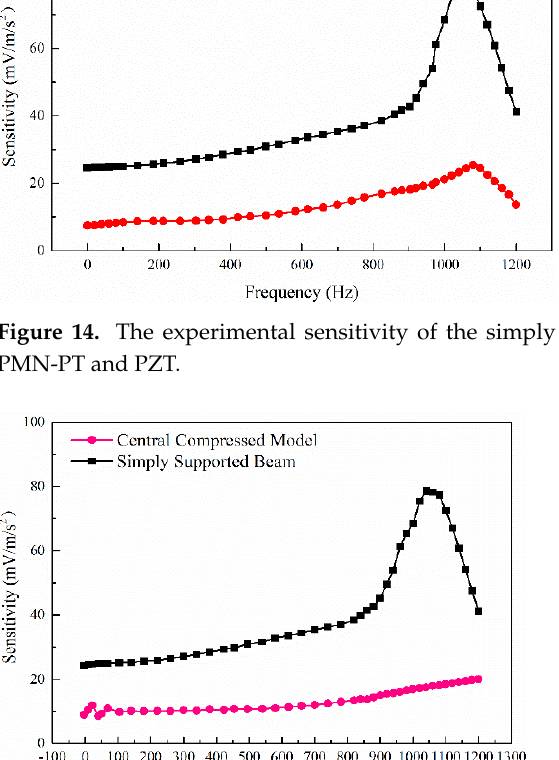
Figure 16. The waveform of different models at 1 Hz. 3.2. Output Results of the Data Acquisition System The model of the piezoelectric transducer is fixed on the vibration exciter, and the collected signals are output to the designed charge amplifier circuit. According to the re- sults of the previous tests, the charge sensitivity of the piezoelectric transducer model is 2.48 pC/ms − 2 . Applying a sine wave signal with a frequency of 160 Hz and acceleration of 15.8 m/s 2 on the vibrating exciter, the voltage value should be 39.18 mV by the calculation formula (3) of the charge conversion circuit. The magnification of the charge amplifier circuit is set to 50 times, the voltage sensitivity of the piezoelectric accelerometer after the charge amplifier is 124 mV/ms − 2 , and the theoretical output voltage value should be 1.959